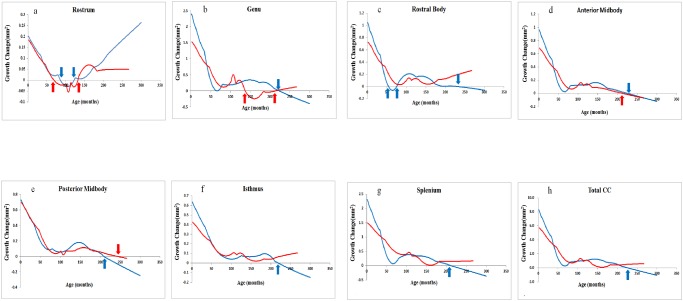
Rate of monthly growth change for (a) rostrum, (b) genu, (c) rostral body, (d) anterior midbody, (e) posterior midbody, (f) isthmus, (g) splenium, (h) total corpus callosum.Positive values indicate increasing size of the area. The point of intersection on the x-axis represents the age of local maximal area. Blue line: males’ LOESS (n = 61), red line: females’ LOESS (n = 53). The arrows show the local maximum for each region calculated using LOESS. For the rostrum, there were local maxima beyond 24 months (2 years) for both females and males, 69 (5.9 years) and 132 months (11 years) old for females and 86 (7.2 years) and 122 months (10.2 years) for males. For the genu, females had two local maxima at 137 (11.5 years) and 214 months (17.1 years), whereas males had only one local maximum at 223 months (18.7 years). For the rostral body, local maxima were observed only in males (55 (4.7 years), 75 (6.3 years), and 233 months (19.5 years)). For the anterior and posterior midbodies, local maxima were observed only once for both sexes (for females at 211 (17.7 years), males at 224 months (18.8 years); for females at 243 (20.3years), males at 209 months (17.5 years), respectively). For the isthmus, splenium and entire corpus callosum, single local maxima were observed only for males (219 (18.3 years), 212 (17.8 years) and 226 months (18.1 years), respectively).